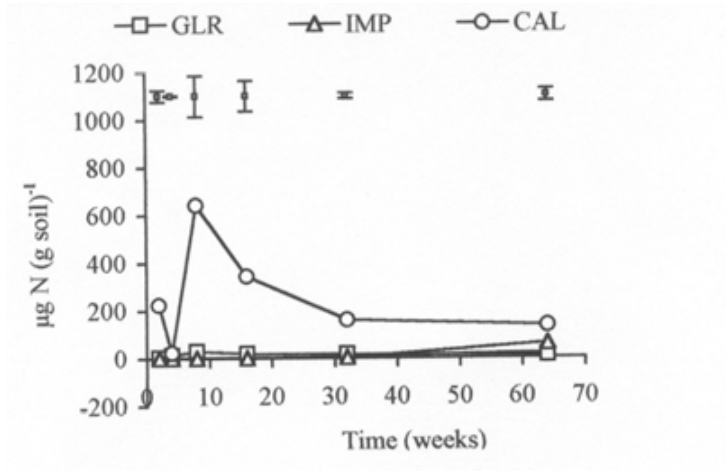
Figure 1. NH 4 -N accumulation in a tropical soil treated with GMs. GLR = Gliricidia, IMP = Imperata and CAL = Calopogonium. Bars = LSD 0.05 . .